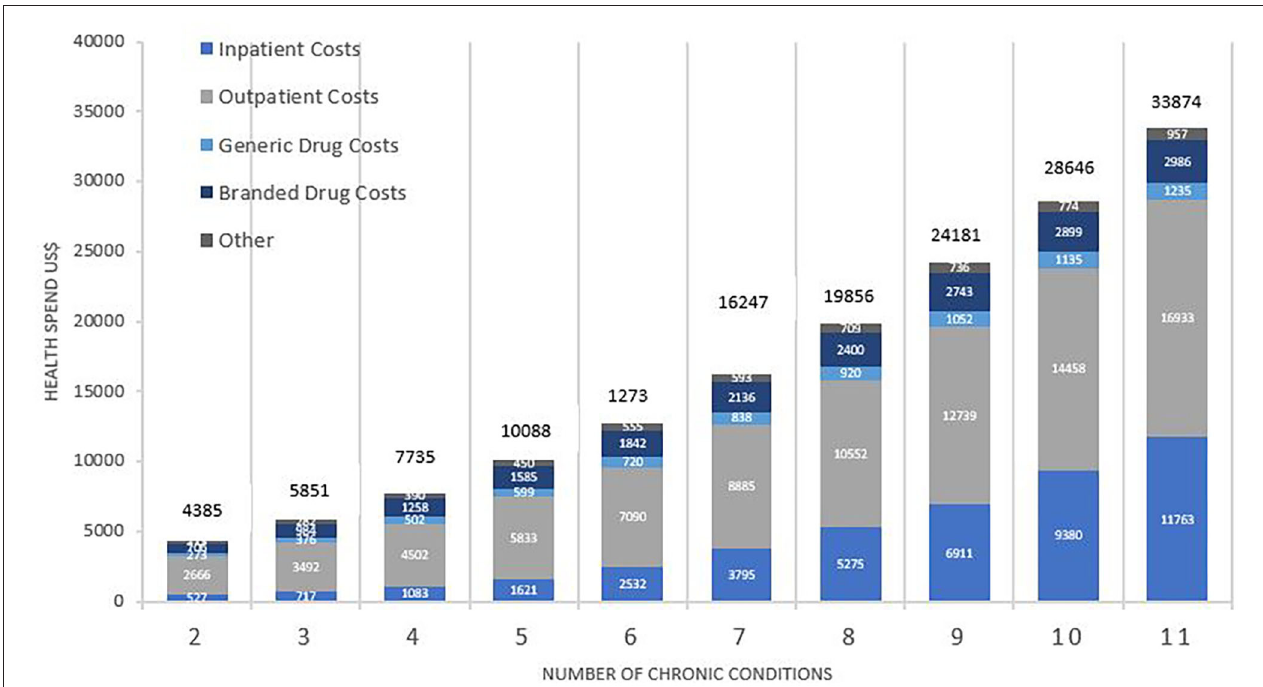
FIGURE 1 | Total average health spend and contributors to cost by number of chronic conditions. Costs are weighted to the US population and are reported in US$. Comparison between costs by number of conditions was statistically significant overall ( p < 0.001), for inpatient ( p < 0.001), outpatient ( p < 0.001), branded drugs ( p < 0.001), and generic drugs ( p <